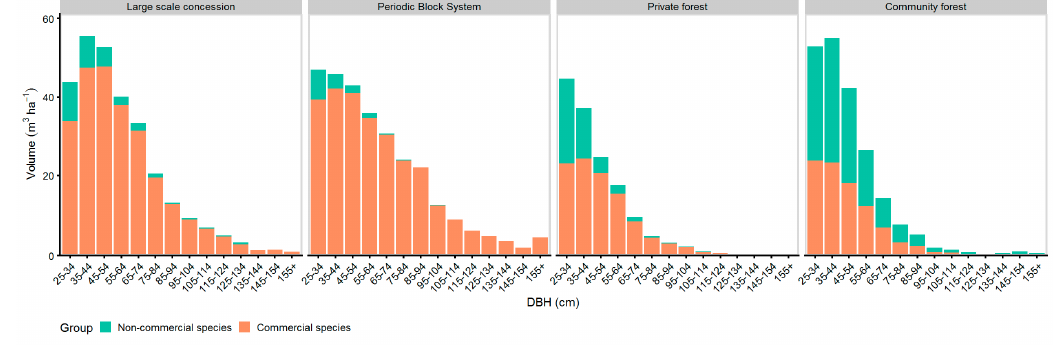
Figure 5. Volume-DBH distribution of commercial and non-commercial